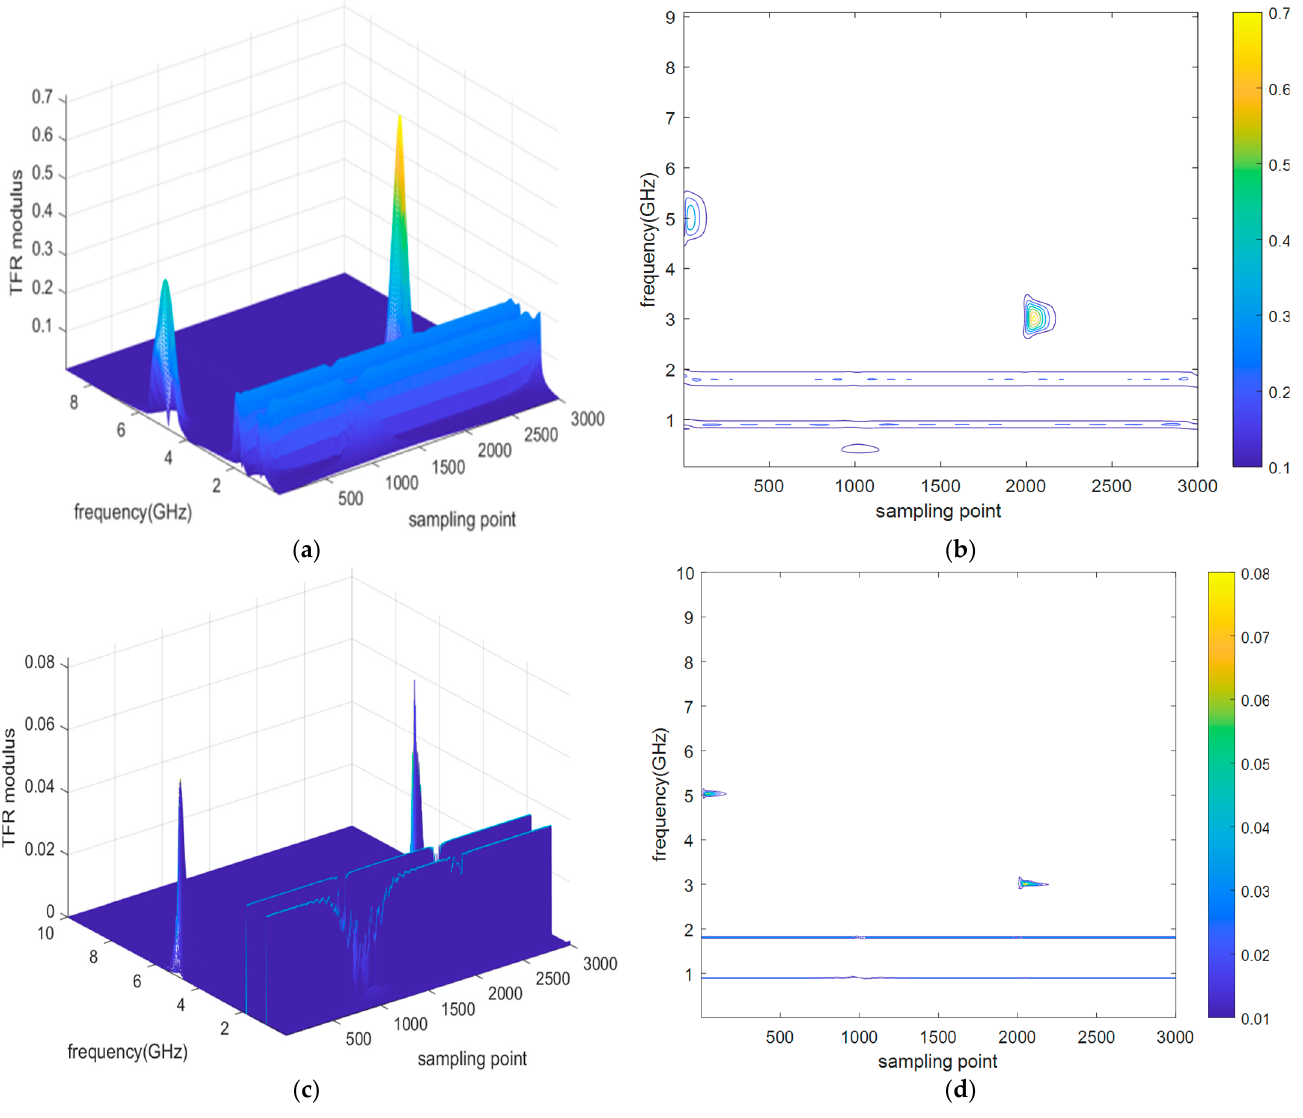
Figure 5. CWT TFR and the reassigned TFR. ( a ) CWT TFR, ( b ) contour of CWT TFR, ( c ) reassigned TFR, and ( d ) contour of reassigned TFR.